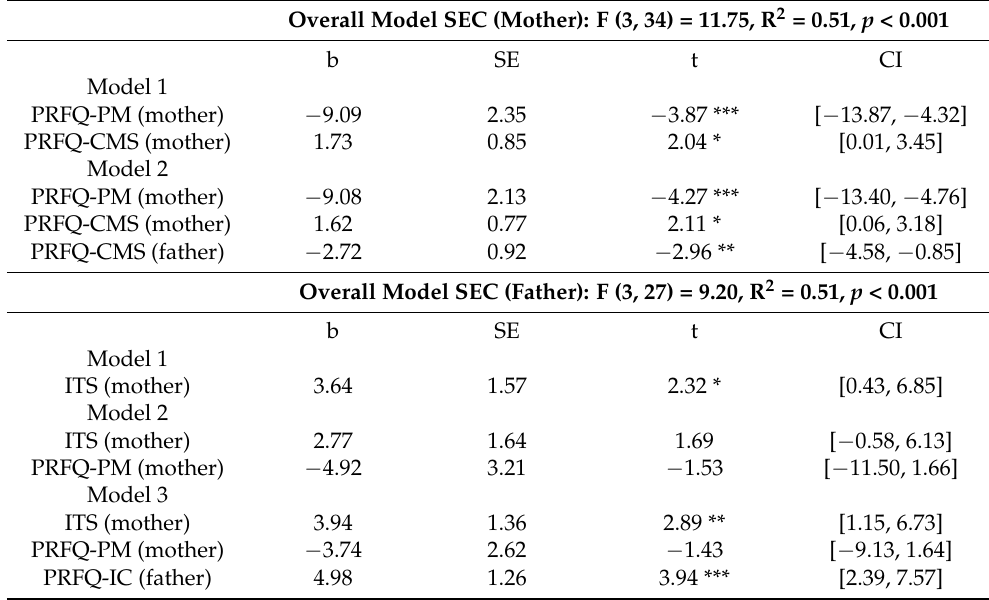
Table 5. Hierarchical multiple regression models predicting a child’s social–emotional